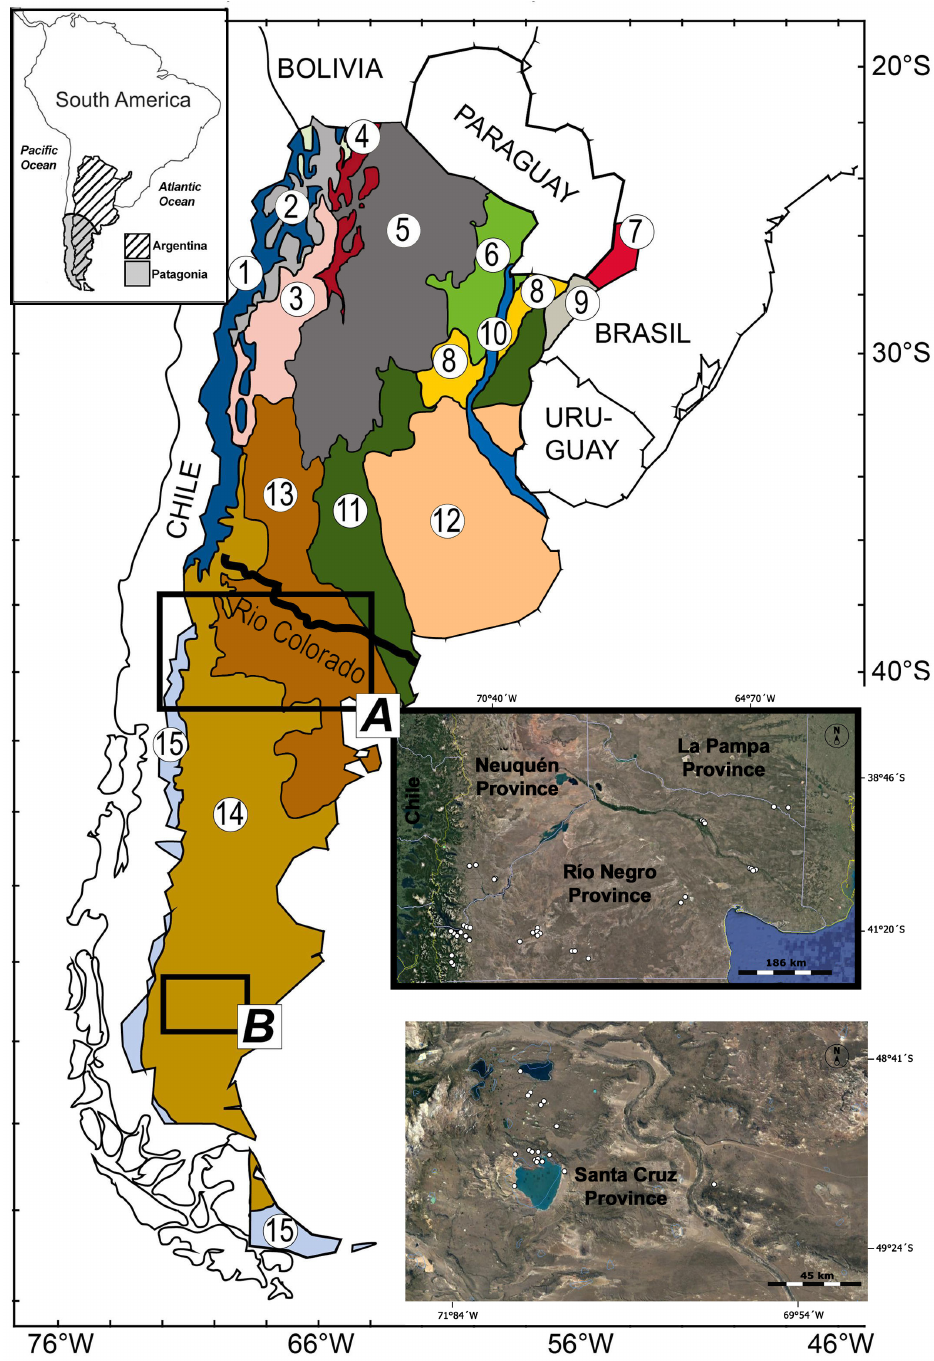
Figure 1. Study area and Argentinian ecoregions (after Burkart et al. 1999) (a) 1 - Altos Andes (dark blue), 2 - Puna (light gray), 3 - Monte de Sierras y Bolsones (light red), 4 - Selva de las Yungas (dark red), 5 - Chaco Seco (gray), 6 - Chaco Húmedo (green), 7 - Selva Paranense (red), 8 - Esteros del Iberá (yellow), 9 - Campos y Malezales (gray), 10 - Delta e Islas del Paraná (blue), 11 - Espinal (dark green), 12 - Pampa (light orange), 13 - Monte de Llanuras y Mesetas (dark orange), 14 - Estepa Patagónica (dark yellow), 15 - Bosques Patagónicos (light blue), redrawn from Burkart et al. (1999). Regional location, boxes indicate study areas A and B and location of the sampling sites (b) sampling sites in study areas A and B (see text for